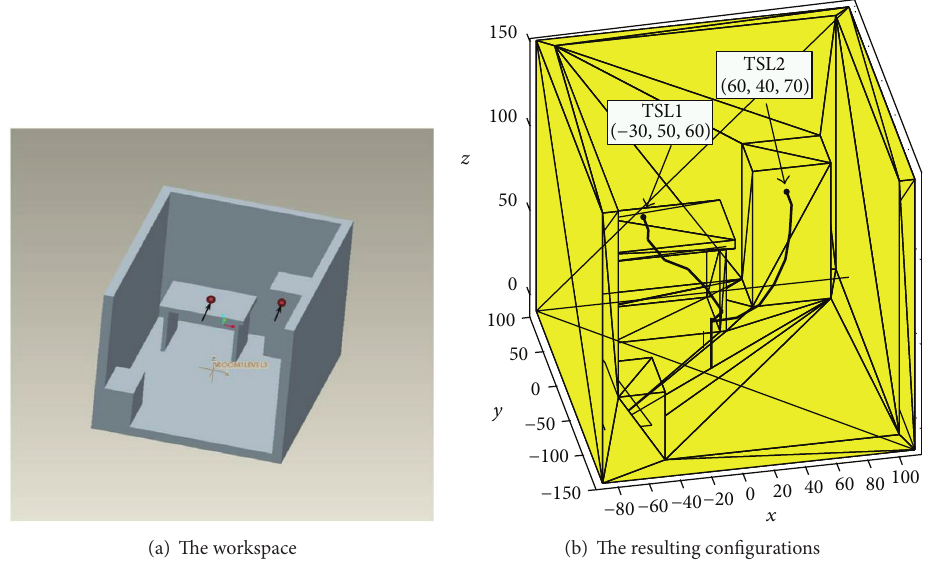
Figure 10: Seven-link manipulator in a room environment with both position and orientation prescribed.